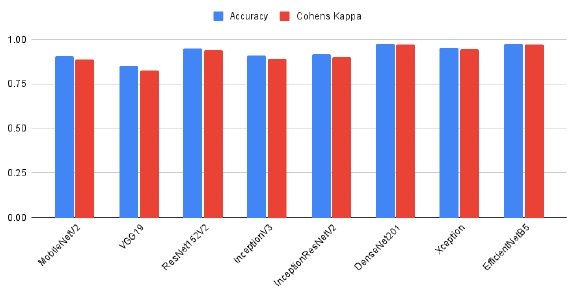
Figure 7: Model accuracy and kappa co-efficient